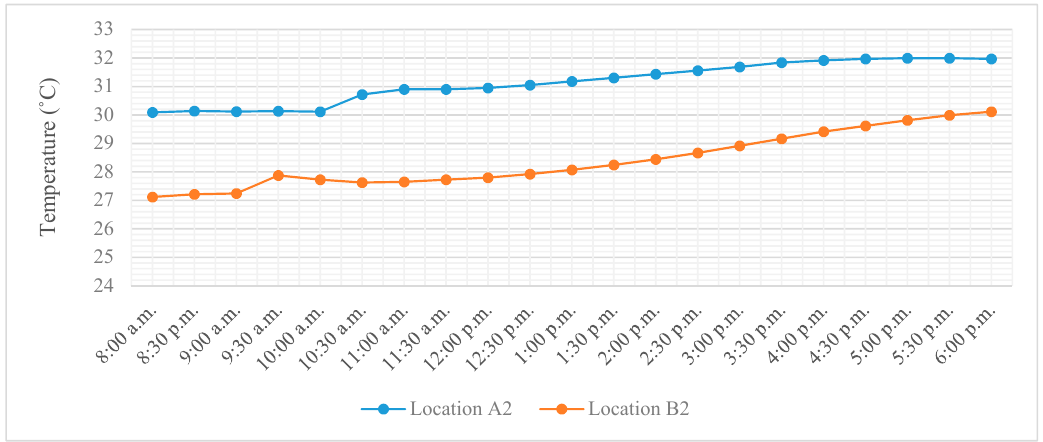
Figure 15. Indoor air temperature in the room of Building A (Location A2) and Building B (Location B2).